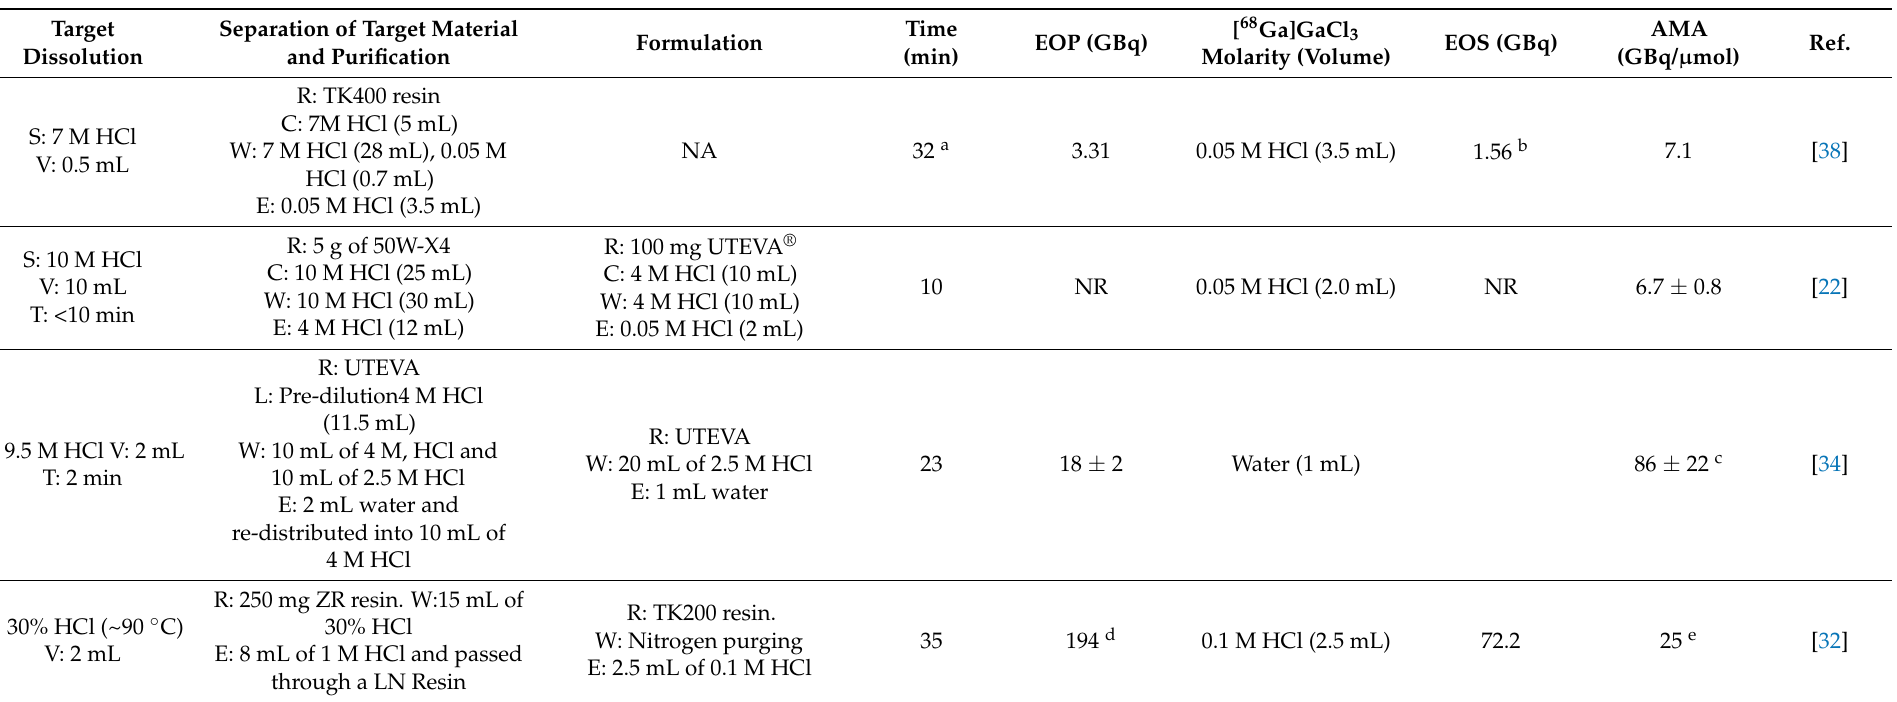
Table 4. Dissolution of solid target for GE PETtrace cyclotron and purification of [ 68 Ga]GaCl 3